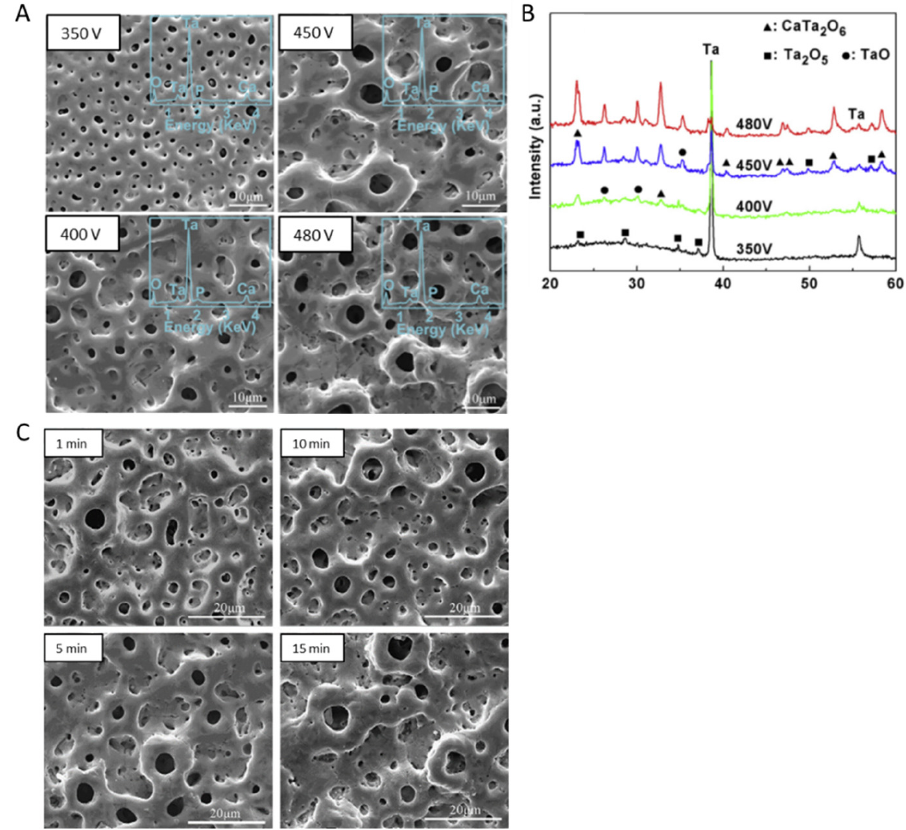
Figure 10. ( A ) Surface morphologies of Ta 2 O 5 treated by MAO at different applied potentials with EDS spectra inset (scale bar 10 μ m), and ( B ) the respective XRD patterns. Adapted from [69], Copy- right 2016 Elsevier. ( C ) Surface morphologies of Ta 2 O 5 treated using MAO process at 450 V for dif- ferent process durations, scale bar 20 μ m. Adapted with permission from Ref. [65]. Copyright 2013 Elsevier.